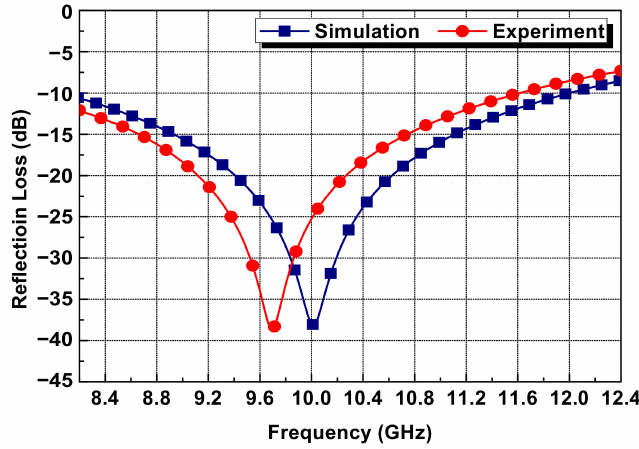
Figure 14. EM wave-absorbing performance of the Salisbury screen